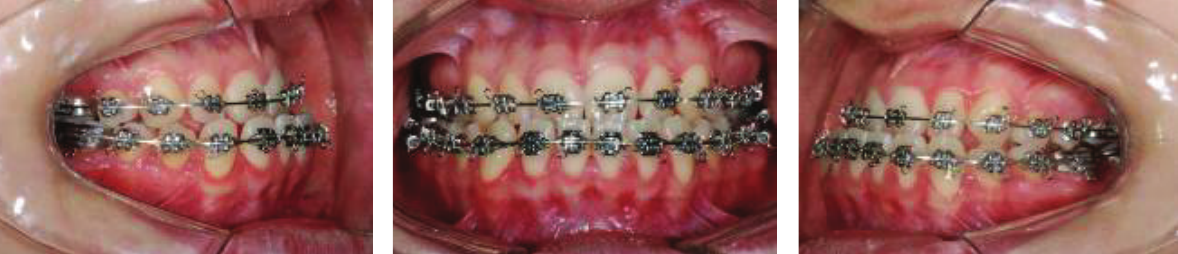
Figure 4: Presurgical intraoral photographs.